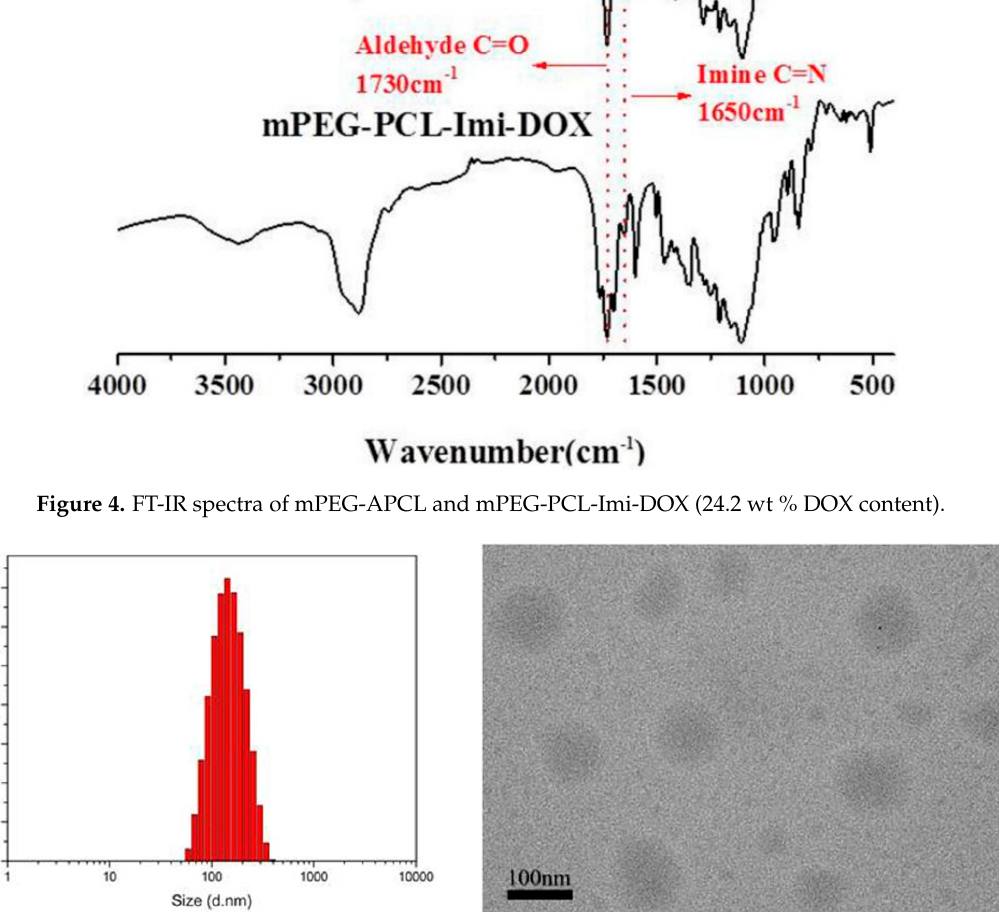
Figure 5. Size distribution profiles of mPEG-PCL-Imi-DOX Micelles determined by DLS ( A ) and TEM ( B ).